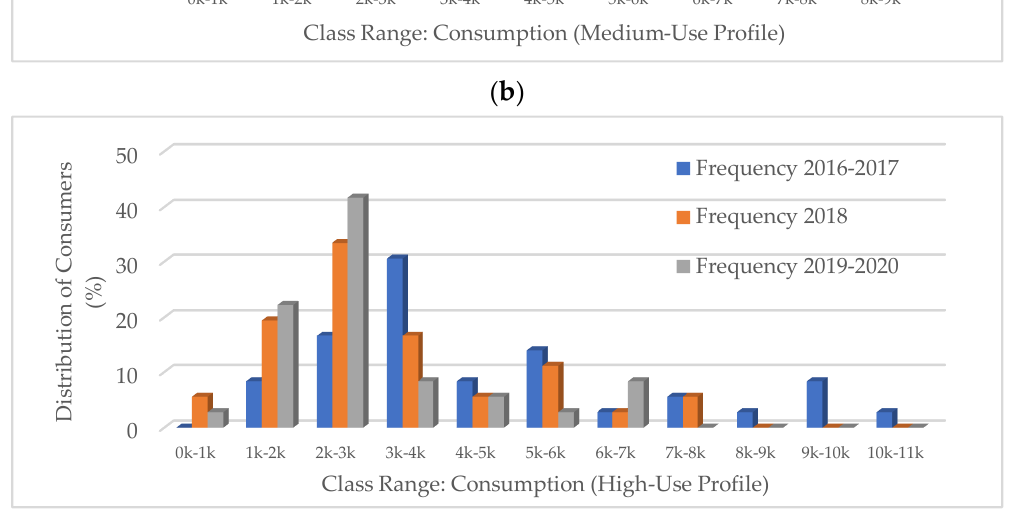
Figure 4. Histogram plots of consumer distribution with respect to consumption ranges at different time intervals: ( a ) low consumption profile; ( b ) medium consumption profile; ( c ) high consumption profile.